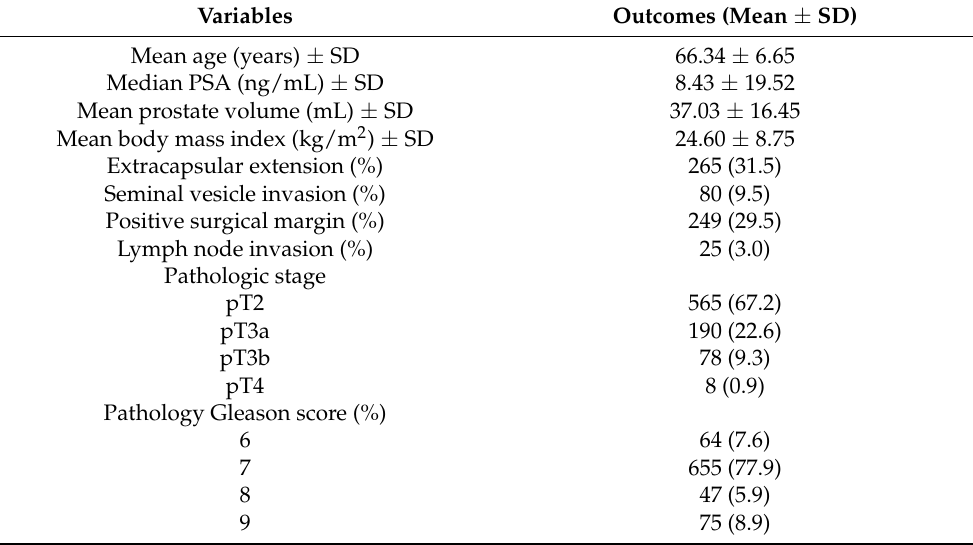
Table 1. Baseline characteristics of total prostate cancer patients who underwent genetic array using exome chip.